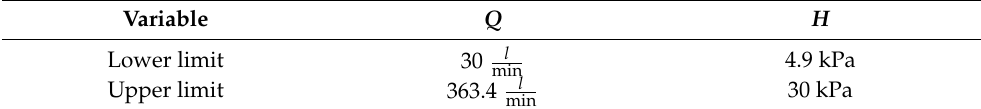
Table 1. Maximum and minimum flow rate and head values in the